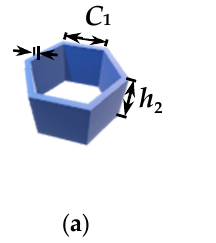
Figure 4. The typical structure of a honeycomb core layer: ( a ) cellular structure and ( b ) 3D con- formed view.